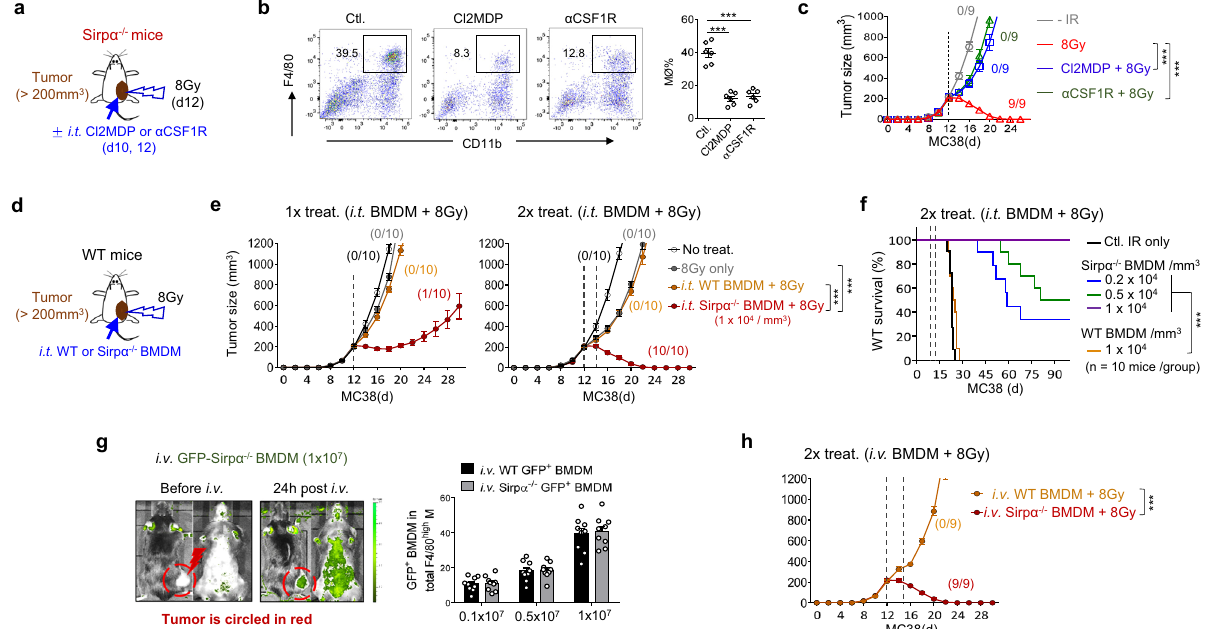
Fig. 2 Sirp α − / − macrophages confer complete responses after IR. a – c Depletion of intratumoral macrophages diminished RT ef fi cacy in Sirp α − / − mice. MC38 tumor-bearing Sirp α − / − mice were administered Cl2MDA-liposomes (Cl2MDP) or anti-CSF receptor antibodies ( α CSF1R) to deplete macrophages starting 2 days prior to IR (8 Gy) ( a ). Depletion of intratumoral macrophages by Cl2MDP or α CSF1R was assessed by fl ow cytometry ( b ). Data from two independent experiments (3 mice/group in each experiment) are presented as mean ± SEM. n = 6 mice in each group. Tumor growth ( c ) in Sirp α − / − mice was monitored after IR with or without macrophage depletion. Data from three independent experiments (3 mice/group in each experiment) are presented as mean ± SEM. n = 9 mice in each group. *** P < 0.001. d , f Combining adoptive infusion of Sirp α − / − BMDMs with RT conferred tumor elimination in WT mice. As depicted in the therapeutic scheme ( d ), MC38 tumors in WT mice were treated once (1×) or twice (2×, 3-days interval) with intratumorally ( i.t .) injected Sirp α − / − or WT (Sirp α + ) BMDMs (1 × 10 4 per mm 3 tumor mass) followed by IR (8 Gy). Tumor size ( e ) and mouse survival rate ( f ) were analyzed. Data from three independent experiments (3 – 4 mice/group in each experiment) are presented as mean ± SEM. n = 10 mice in each group. *** P < 0.001. g Percentage of transferred Sirp α − / − BMDMs (GFP + ) in total intratumoral macrophages 12 h after i.v . injection of Sirp α − / − BMDMs (GFP + ) (0.1 – 1 × 10 7 per mouse). Data from three independent experiments (3 mice/group in each experiment) are presented as mean ± SEM. n = 9 mice in each group. h MC38 tumor growth in WT mice after 2× i.v . injection of BMDMs in combination with IR (8 Gy). Data from three independent experiments (3